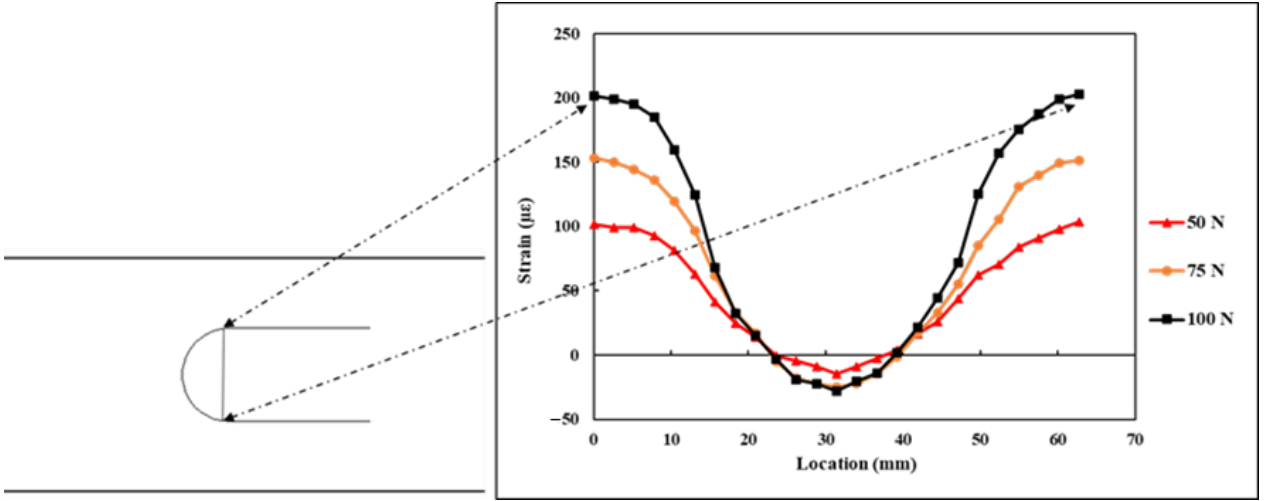
Figure 17. Strains measured by the DFOS under flexural load.